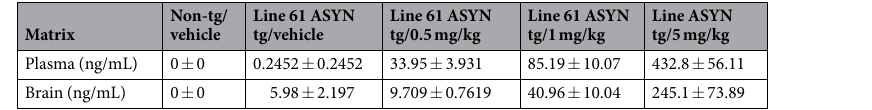
Table 2. Summary of NPT200-11 exposure bioanalysis of plasma and brain homogenates from Line 61 transgenic efficacy study. Exposure data are presented as group means ± standard error of mean for plasma and brain homogenates .